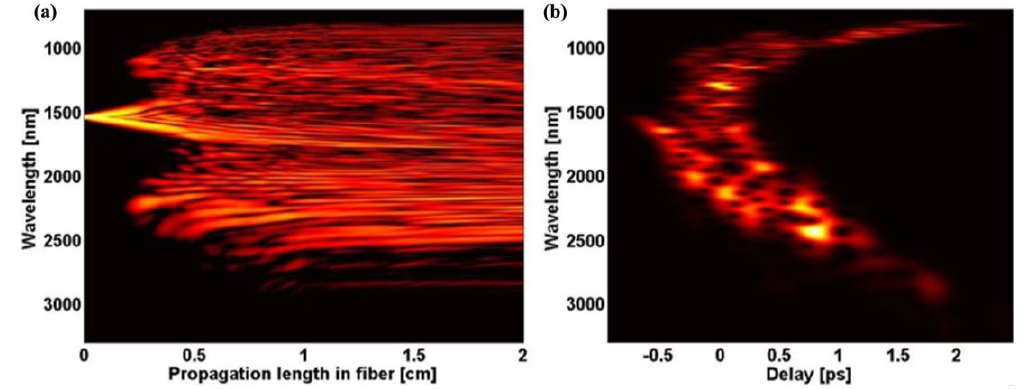
Figure 7. ( a ) Numerically generated evolution of supercontinuum spectrum along the length of PCF; ( b ) corresponding numerical spectrogram at the output of